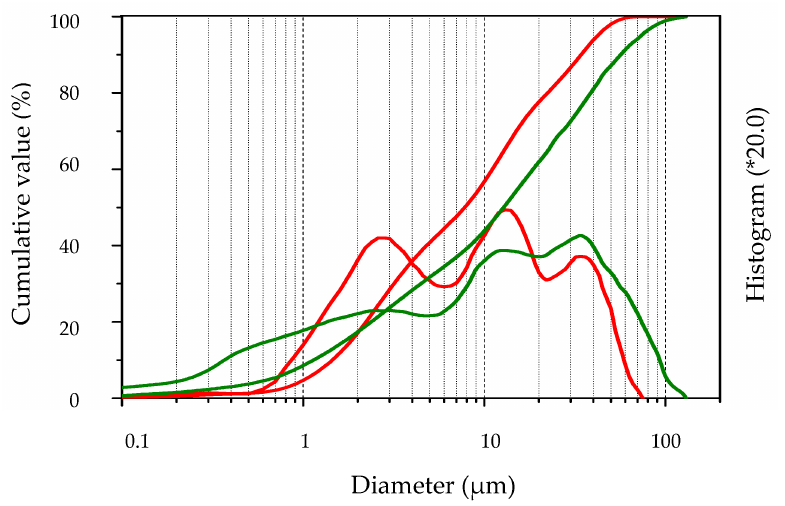
Figure 1. Particle size distribution curves of cement (green) and milled MSWI BA (red). The X-ray of MSWI BA is shown in Figure 2. Qualitative phase analysis of MSWI BA was performed by X-ray diffraction (DRON-7, Russia). A graphite monochromator was used to obtain the X-ray Cu K α spectrum ( λ = 0.15418 nm). The main minerals contained in MSWI BA were found to be quartz and anorthite; the hill at 20–33 ◦ also indicated the presence of amorphous SiO 2 .